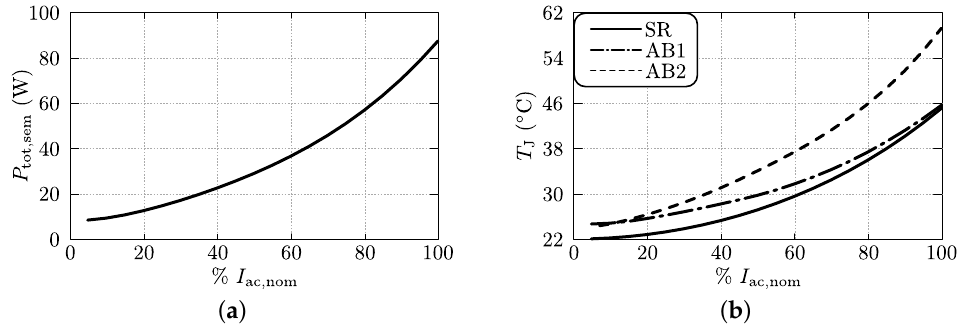
Figure B1. ( a ) Calculated total losses generated by all semiconductors of the DAB and SR; ( b ) Junction temperatures of all semiconductors, i.e., the switches of active bridge 1 (DAB), of active bridge 2 (DAB), and of the SR.